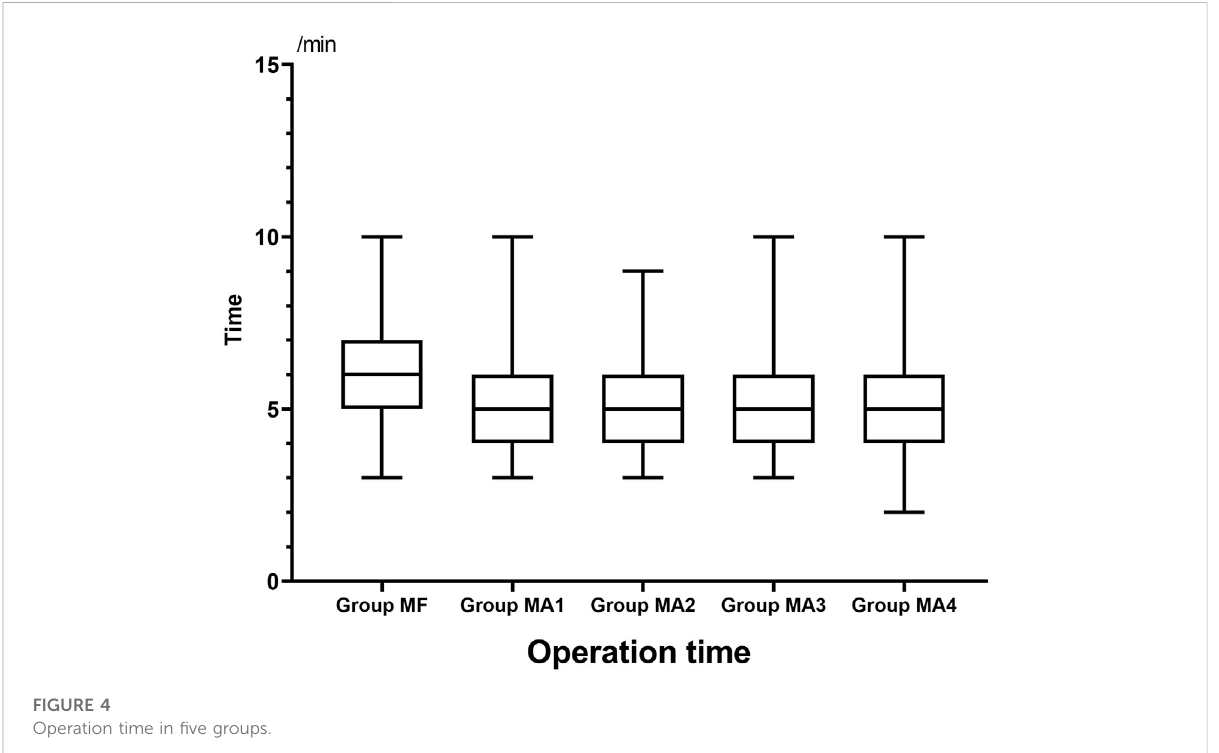
FIGURE 4 Operation time in fi ve groups.